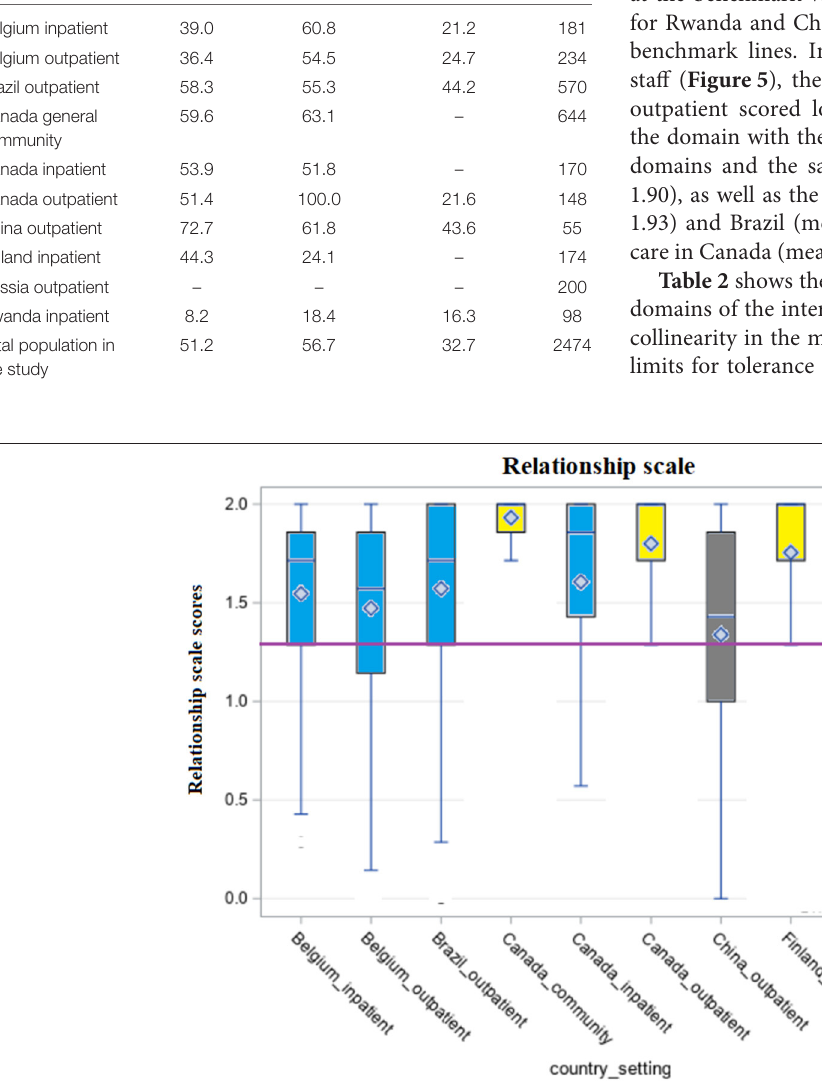
Frontiers in Psychiatry |